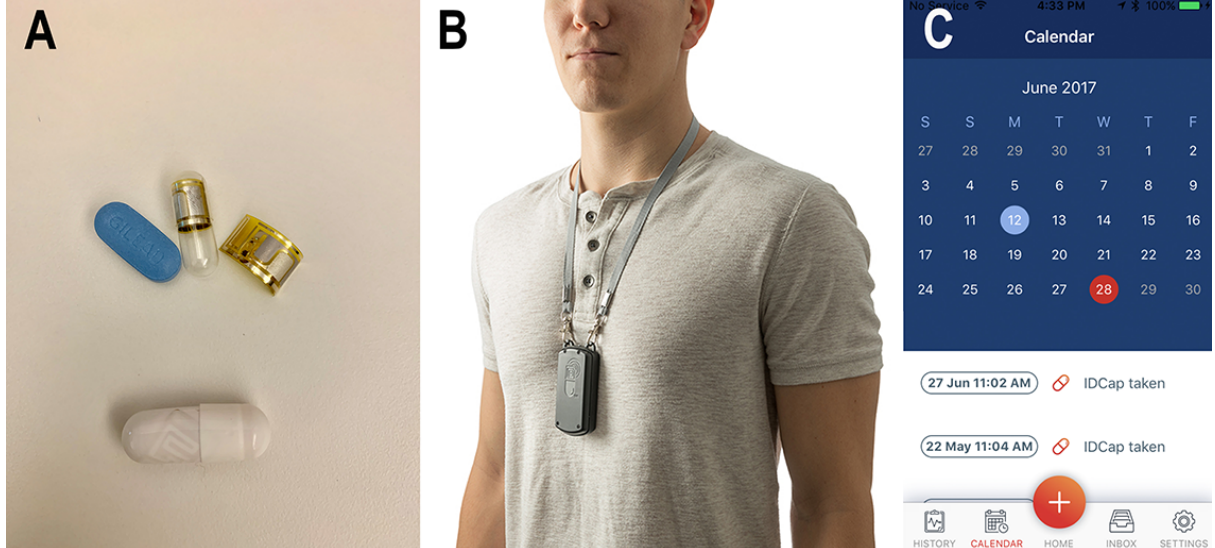
Figure 2. Components of the digital pill system. The digital pill system comprises an ingestible electronic sensor integrated into a gelatin capsule overencapsulating tenofovir disoproxil fumarate/emtricitabine (Truvada) as a digital pill (A). Upon ingestion, the digital pill is activated and emits a radiofrequency signal that is transmitted to a wearable Reader device (B). Ingestion data then flow from the Reader device to a smartphone app